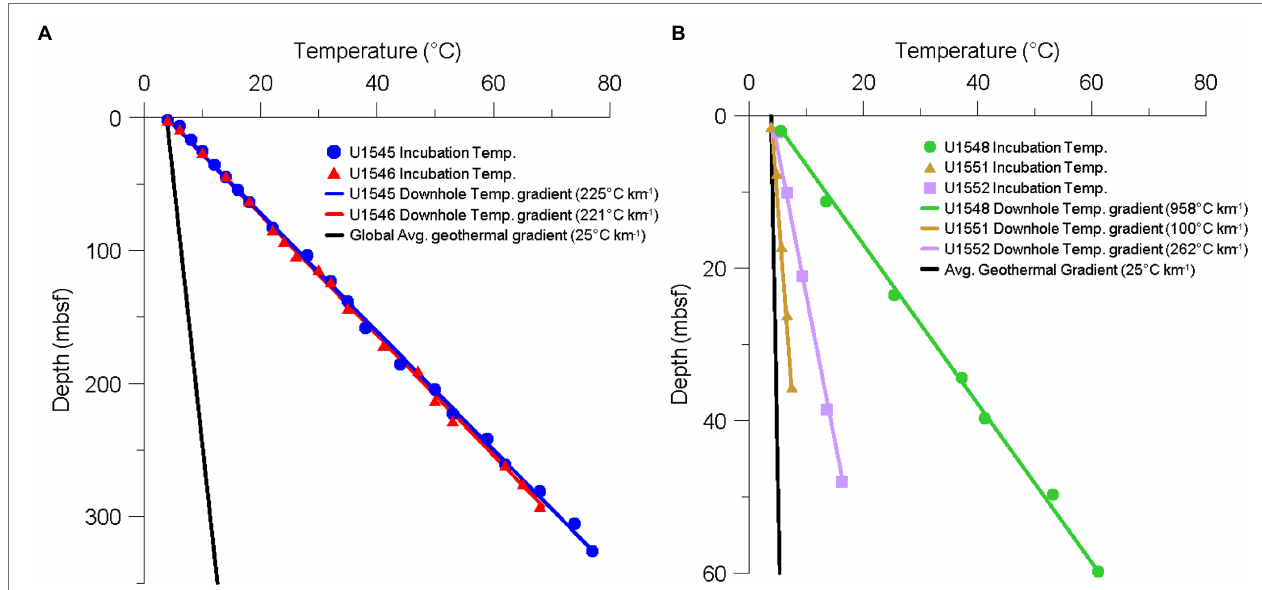
FIGURE 2 | Temperature gradients of the different sampling sites of IODP Exp. 385. (A) Downhole temperature gradients of sites U1545 (blue line) and U1546 (red line) measured in situ . Blue circles and red triangles show sampling depth and incubation temperature of each sample from sites U1545C and U1546D, respectively. (B) Downhole temperature gradients of sites U1548 (green line), U1551 (brown line), and U1552 (purple line) measured in situ . Green circles, brown triangles, and purple squares show sampling depth and incubation temperature of each sample from sites U1548C, U1551B, and U1552B, respectively. The black lines in both figures show the average global geothermal gradient of 25 ° C km − 1 . Note the different depth scales on the two